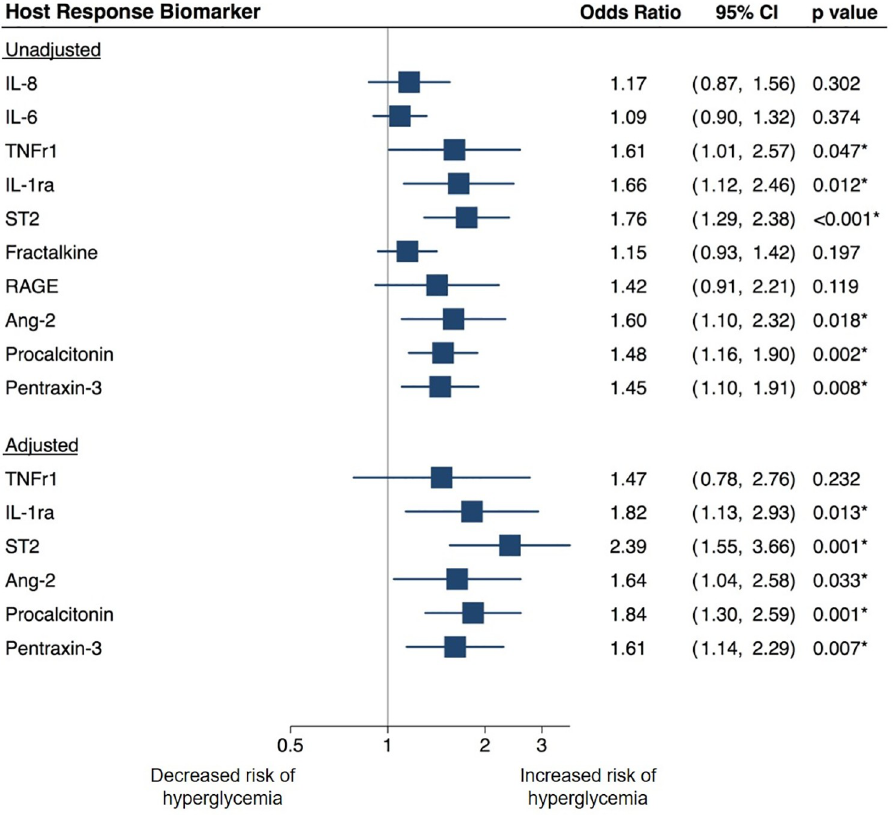
Fig 2. Unadjusted and adjusted associations of host response biomarkers with hyperglycemia. Participants in the “Both Hyperglycemia and Hypoglycemia” group were excluded in this analysis. Biomarker levels were log transformed prior to analysis. Reported p-values have been adjusted for multiple comparisons. Multivariate analyses were adjusted for age, history of diabetes, total glucocorticoid dose, and SOFA score. Abbreviations: Ang2: Angiopoetin 2; IL-6: Interleukin-6; IL-8: Interleukin-8; RAGE: Receptor for advanced glycation end-products; ST2: Suppressor of tumorigenicity 2; TNFr1: Tumor-necrosis factor receptor 1.